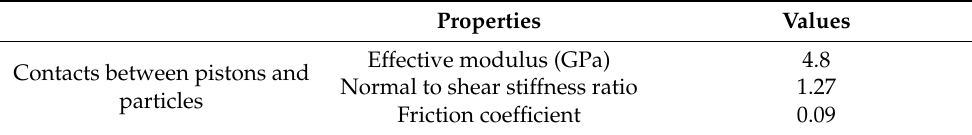
Table 2. Parameter set for the contacts between particles and